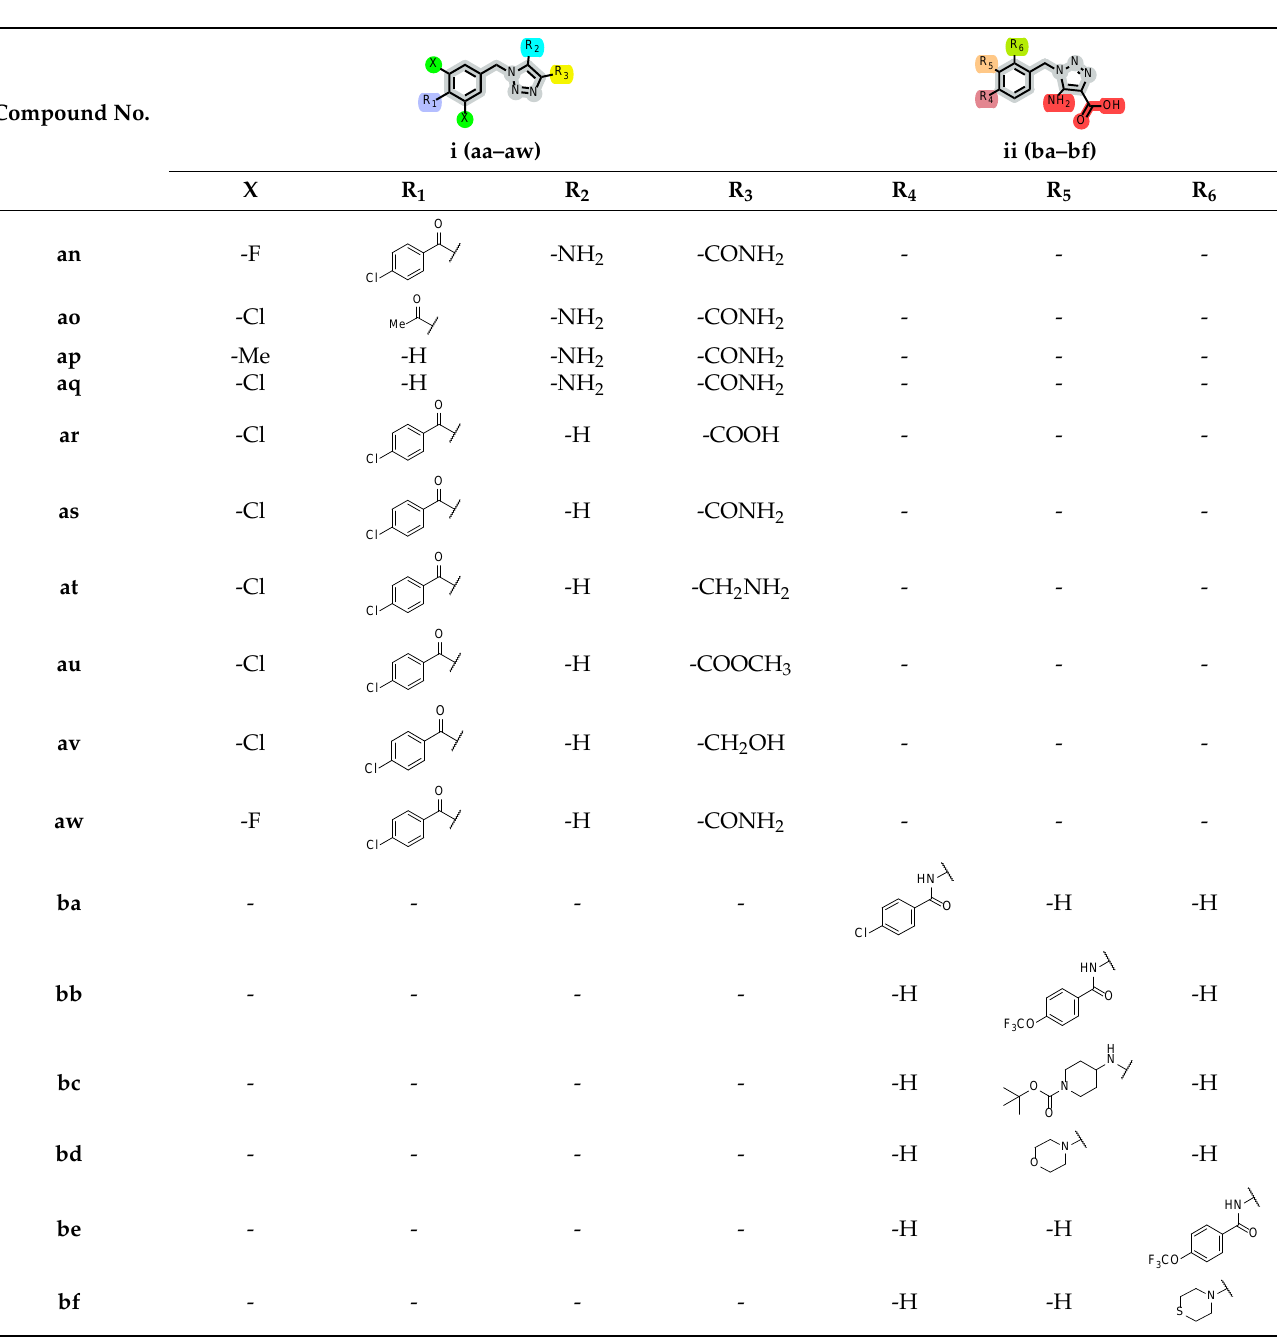
Table 1. Cont. Table 1. List of aa compound derivatives and corresponding structures. Table 1. List of aa compound derivatives and corresponding